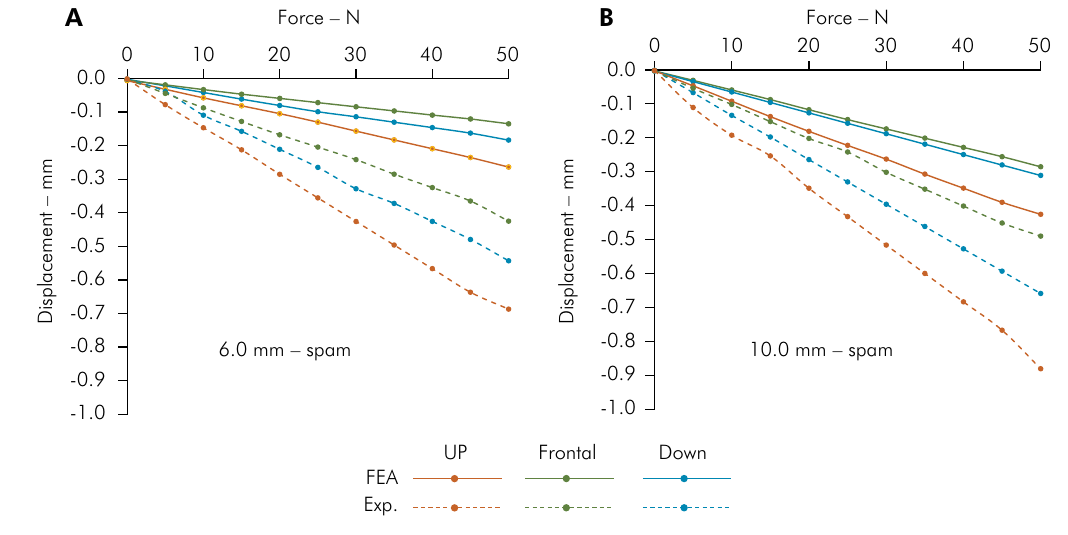
Figure 7. Force (N) versus displacement (mm) relations obtained from finite element analysis (FEA) or experiments during the three-point bending tests with rat tibia for 2 span distances and three bone defect positions (frontal, upward and